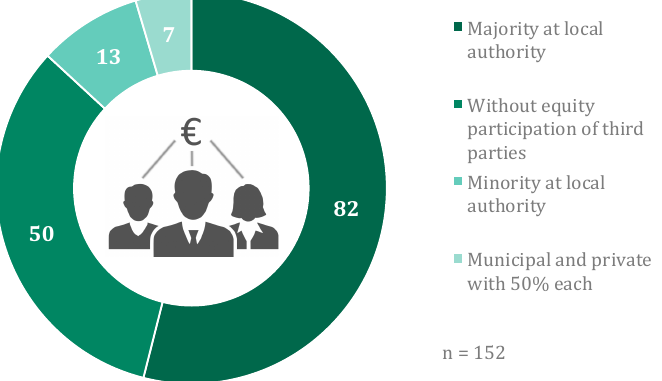
Figure 1. New municipal utilities in Germany and their ownership structure.